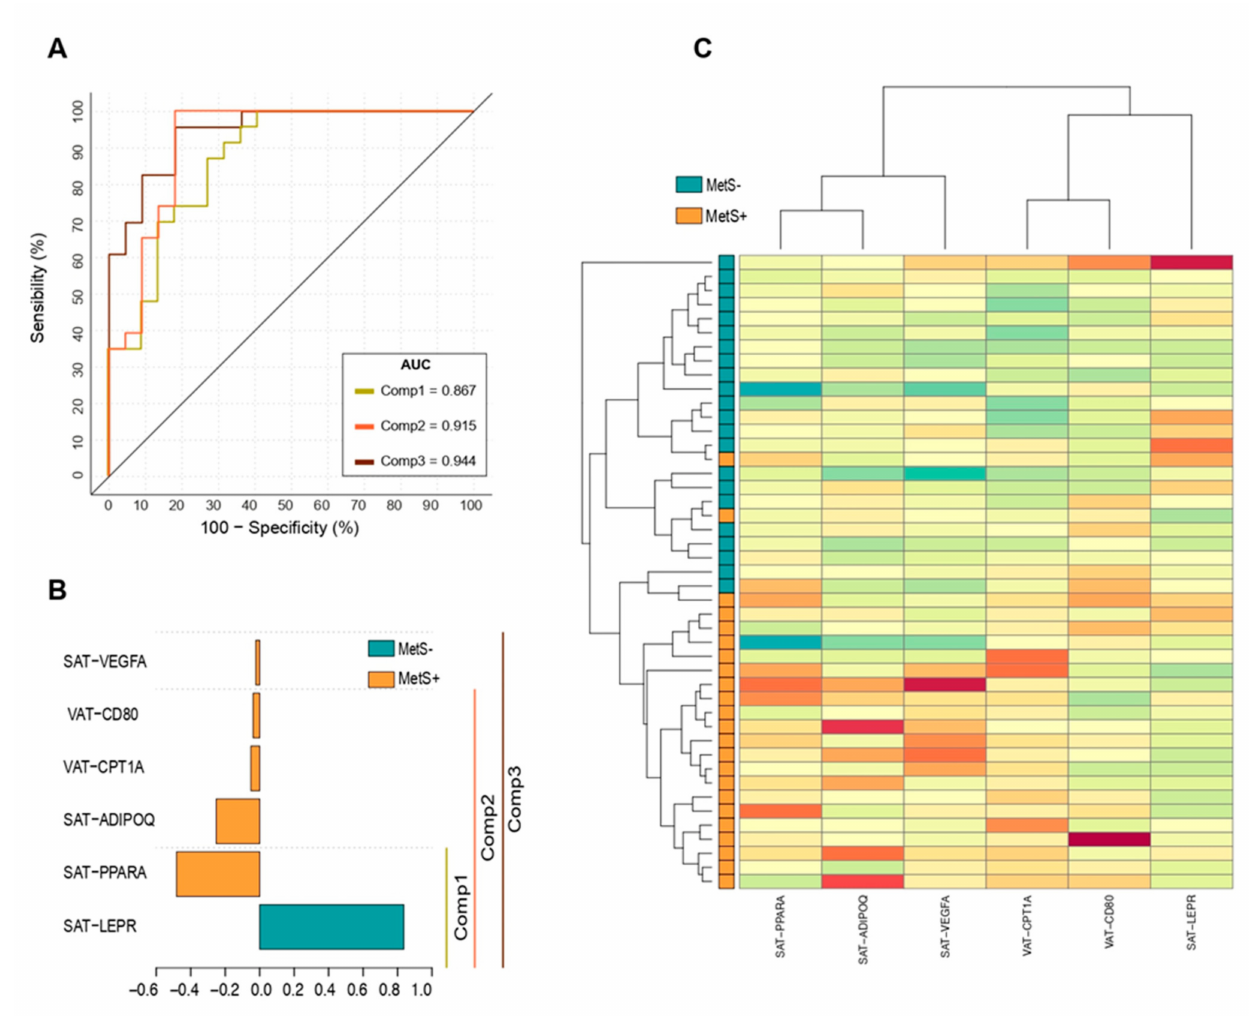
Figure 2. Subcutaneous and visceral fat gene expression signature model for MetS. ( A ) sPLSDA receiver operating characteristic (ROC) analysis of the gene expression signature components. Lines correspond to the accuracy classification performance of each component, including the previous. ( B ) sPLSDA loading plot. Bar length corresponds to each gene loading weight (importance) into the model. Bar color indicates the group in which the mean gene expression is higher. ( C ) Gene expression hierarchical dendrogram heatmap of the transcriptome signature. Euclidean distance metric with Ward’s group linkage algorithm was performed to cluster groups. MetS − , severely obese without MetS; MetS+, severely obese with